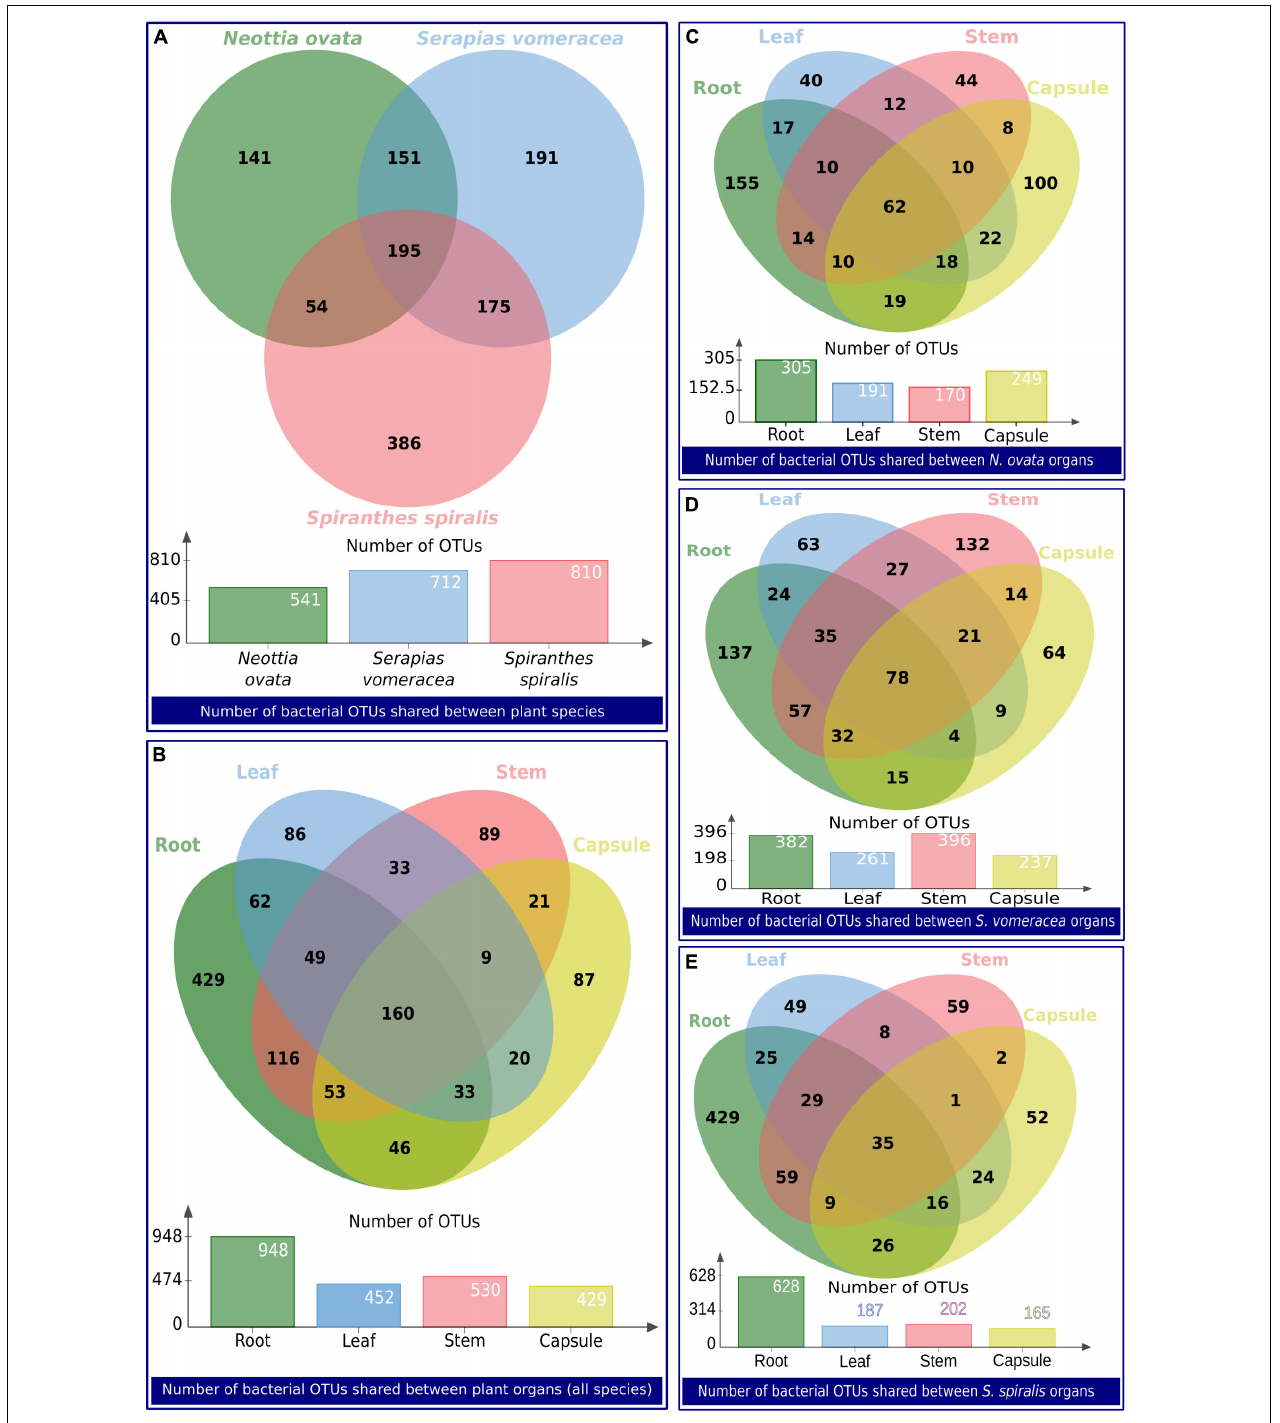
FIGURE 6 | Venn diagrams showing the number of bacterial OTUs shared between groups of samples. The groups of samples are indicated as a label below each diagram.